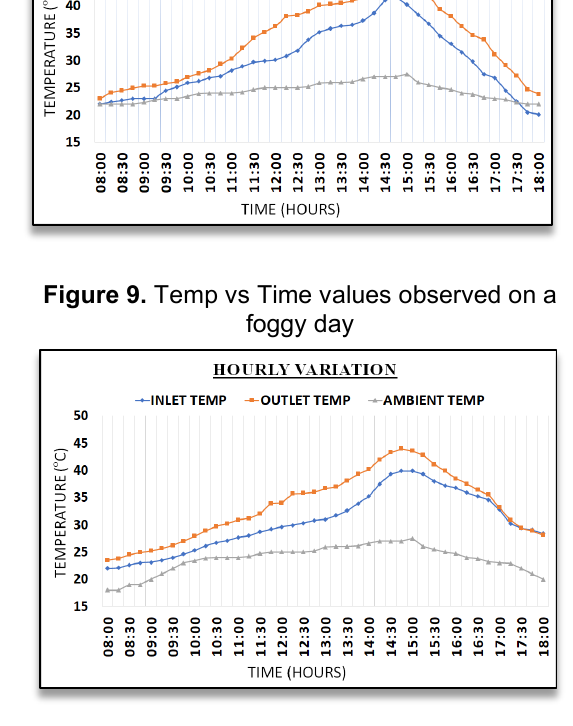
Figure 10. Temp vs Time values observed on